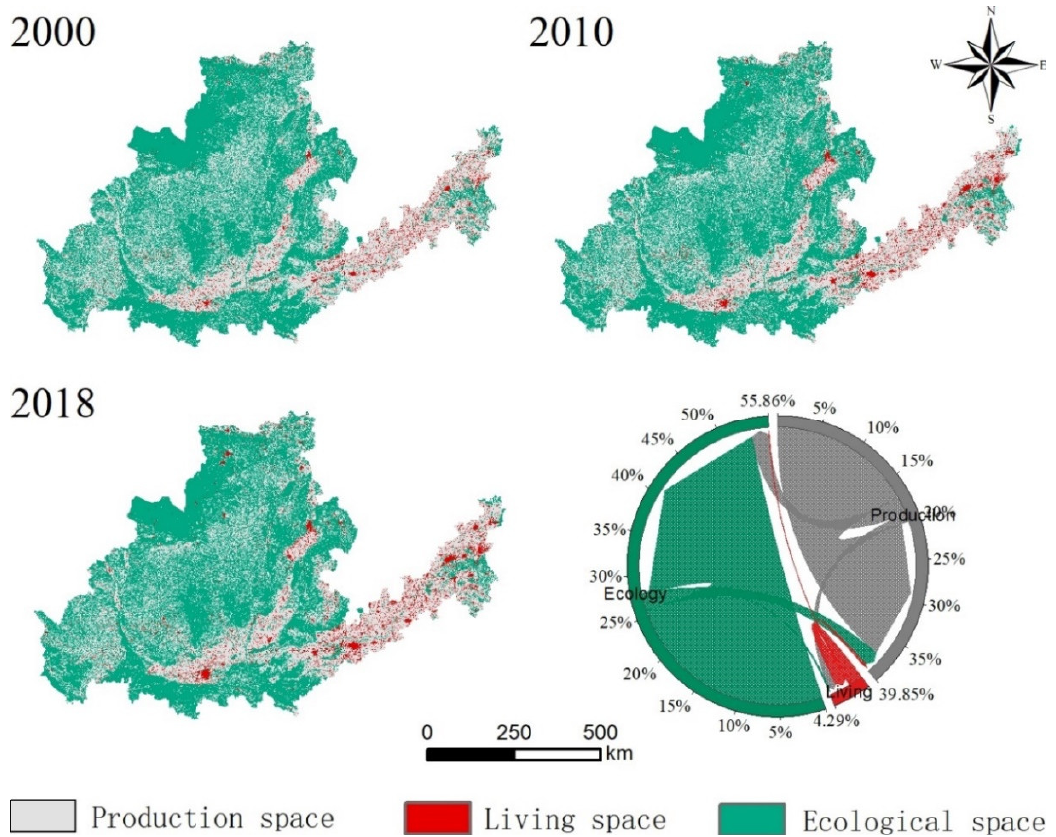
Figure 3. Structure and transition of production-living-ecological space in the Yellow River Basin from 2000 to 2018.